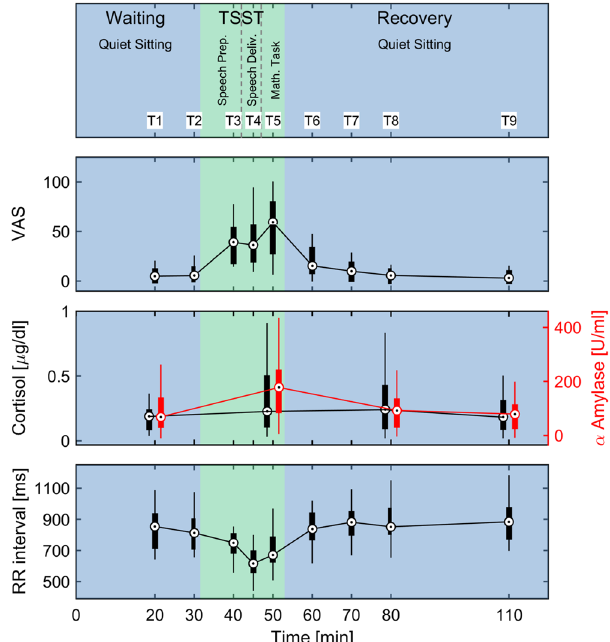
Figure 1. Experimental design, course of established stress parameters. The central circle represents the median; the boxplots represent the distribution from 25%- to 75%-percentile. The Whiskers represent remaining data distribution from minimum to maximum.